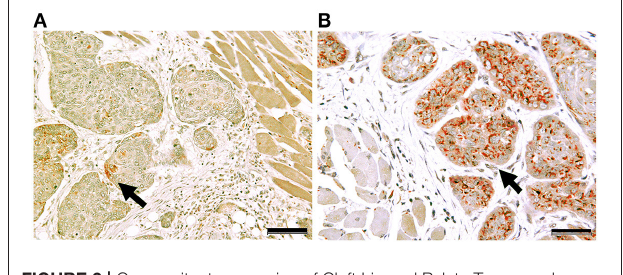
FIGURE 2 | Concomitant expression of Cleft Lip and Palate Transmembrane 1-Like 1 (Clptm1L) and TMEM207 in OSCC cells. Double immunohistochemical staining showed that the Clptm1L, Cleft Lip, and Palate Transmembrane 1-Like (Clptm1L) immunoreactivity (brown color) and TMEM207 immunoreactivity (red color) were co-localized in OSCC cells during cancer invasion in a case of poor outcome (B) . In contrast, little Clptm1L or TMEM207 immunoreactivity was found in a case with a favorable outcome (A) . Arrows indicate positive staining. Bar indicates 50 µ m. TABLE 3 | Correction between Clptm1L and TMEM207 immunoreactivity and clinicopathological factors. Clpmt1L2.TMEM207